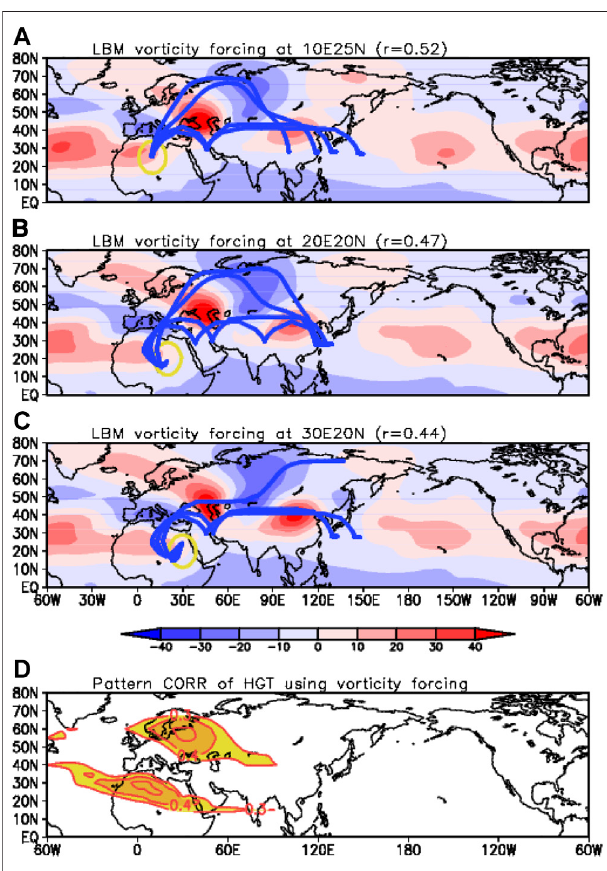
FIGURE 6 | The LBM experiment using vorticity forcing migrating in 5 ° interval over the Northern Hemisphere. Geopotential height anomaly at 200 hPa in LBM simulations using negative vorticity (anti-cyclonic) forcing (A) 10 ° E 25 ° N, (B) 20 ° E 20 ° N, and (C) 30 ° E 20 ° N is illustrated. The yellow circle denotes the vorticity forcing area, and the blue line shows the Rossby wavepropagationpath.Thepatterncorrelationcoef fi cientbetweenEOF1and LBM simulations is calculated at each forcing point (D)